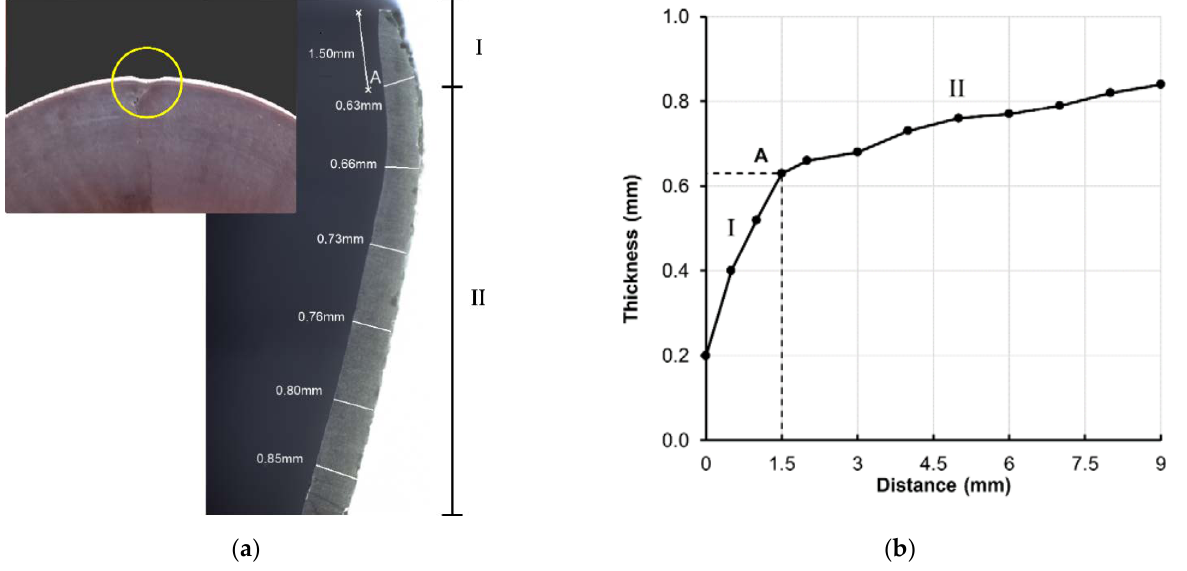
Figure 9. ( a ) Detail of a tube section after the incremental expansion and ( b ) evolution of the tube wall thickness with the longitudinal distance to the upper tube end.